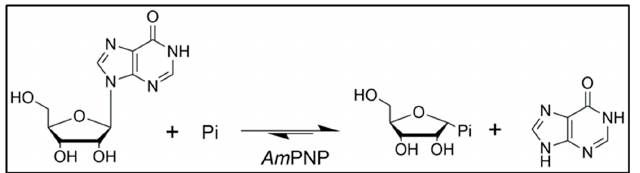
Table 2. Kinetic parameters for Am PNP with various purine nucleosides.